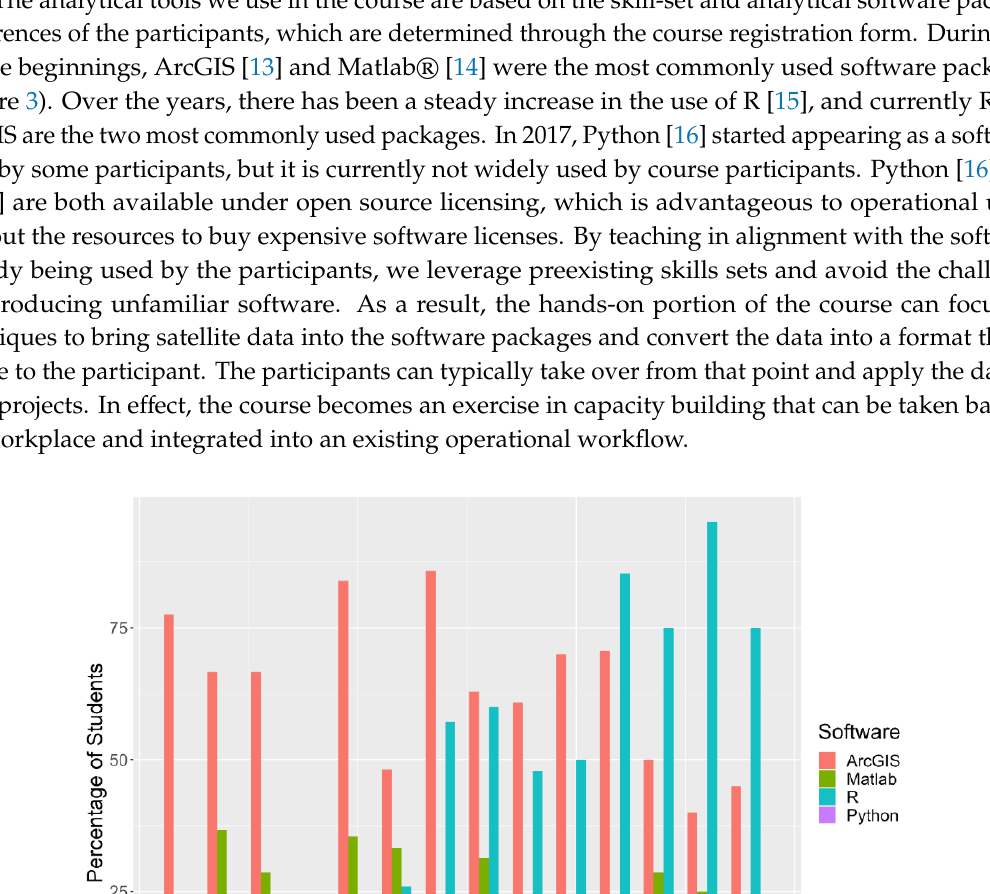
Figure 2. Affiliations of the 355 participants who have taken the NOAA Satellite Course since 2006. NMFS and NOS are the line offices within NOAA that deal with the oceans.